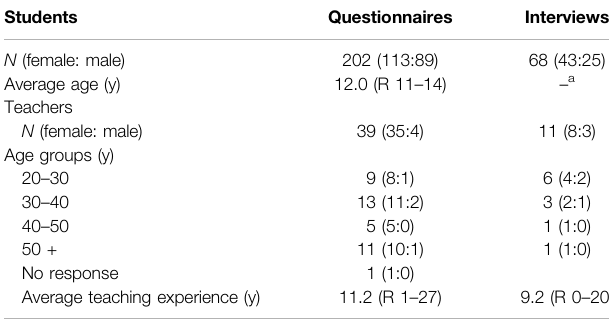
TABLE 2 | Gender, age and teaching experience for participants in the two main types of data